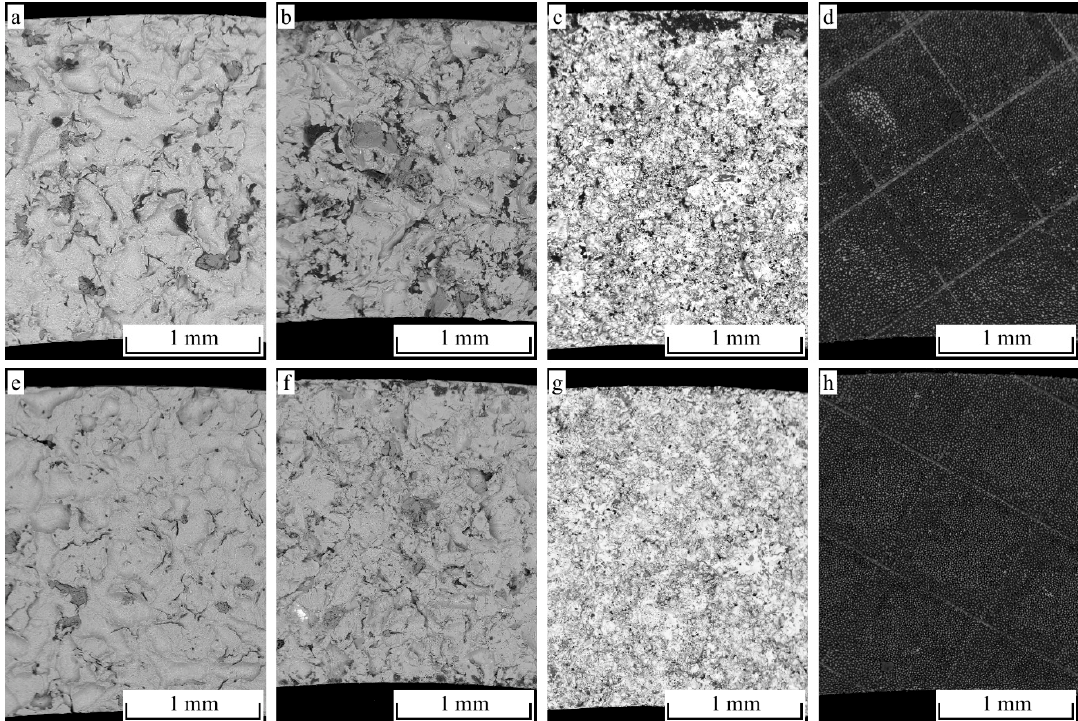
Figure 15. Fracture analysis (SEM-images back-scattering detector (BSD) contrast) of the tested hollow cylinder specimens. Shear- ( a–d ) and tensile- ( e–h ) loaded specimens are depicted for the differently structured surfaces: ( a, e ) F16, 3 bar + 5 min NaOH, ( b, f ) F16, 2 bar ( c, g ) NiAl5 coating and ( d, h ) pin structure.